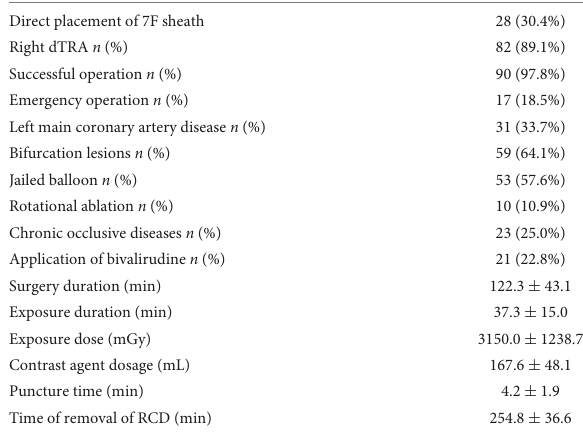
TABLE 3 Procedural